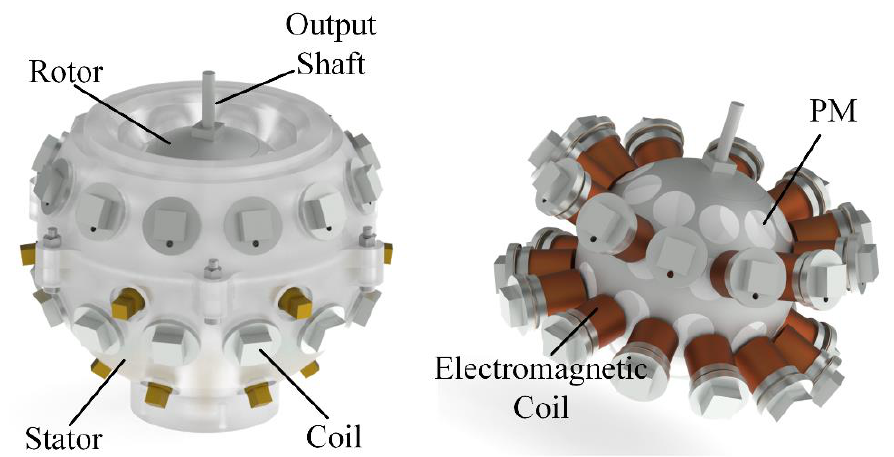
Figure 1. PMSpA structure diagram.